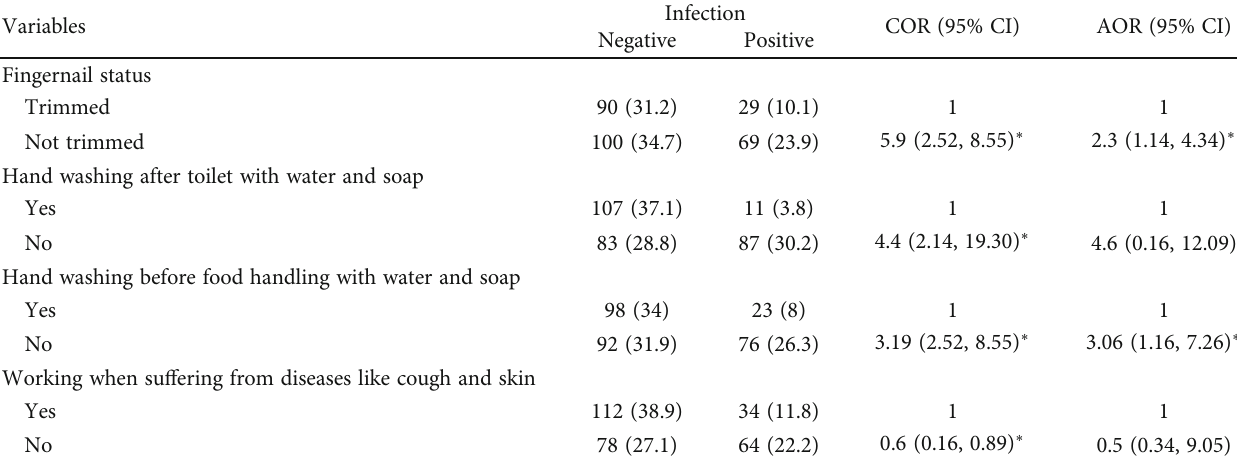
Table 3: Multivariate logistic regression analysis of predictors (personal hygiene variables) for parasite infection among food handler ’ s working in Goba town, Ethiopia, 2020 ( n = 288